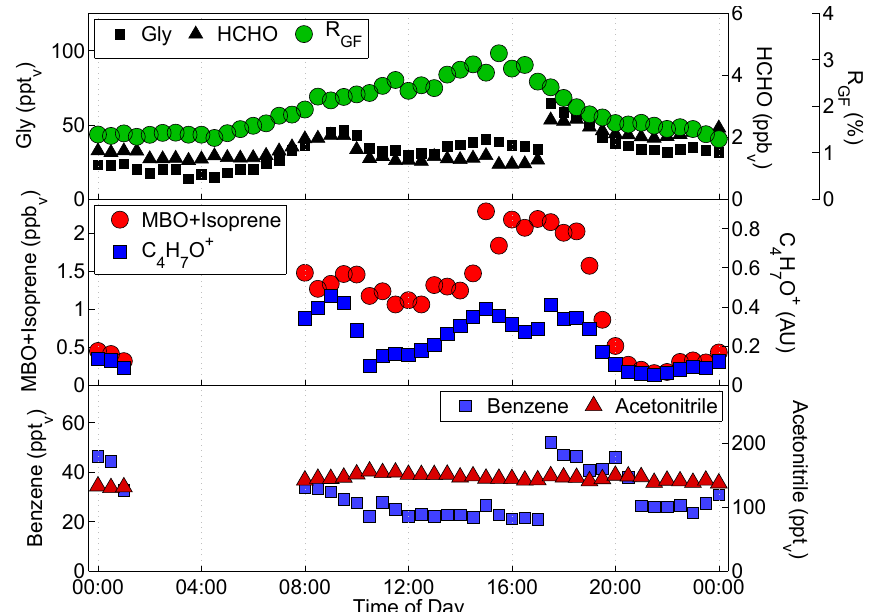
Fig. 3. Gly, HCHO, R GF and other tracer species during day BN1 (DOY 230). Gly, HCHO, and R GF are shown as 30 min binned averages ( ± 15 min each half hour), whereas other species are shown at full resolution. Data for MBO+Isoprene, C 4 H 7 O + , benzene, and acetonitrile were measured via